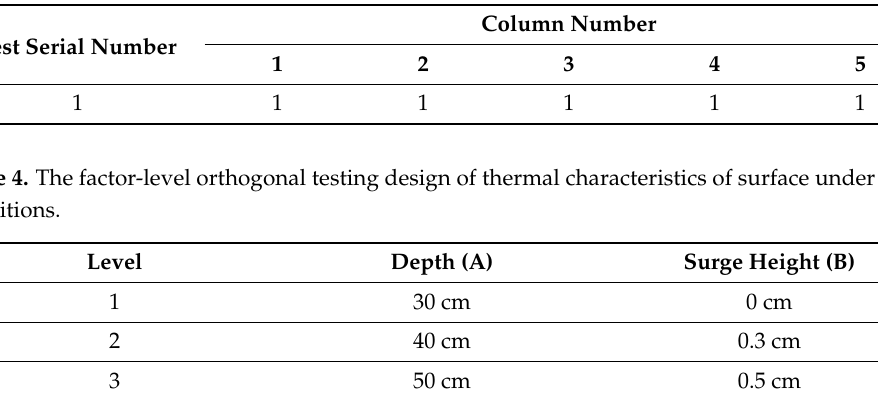
Table 3. The form of orthogonal table.